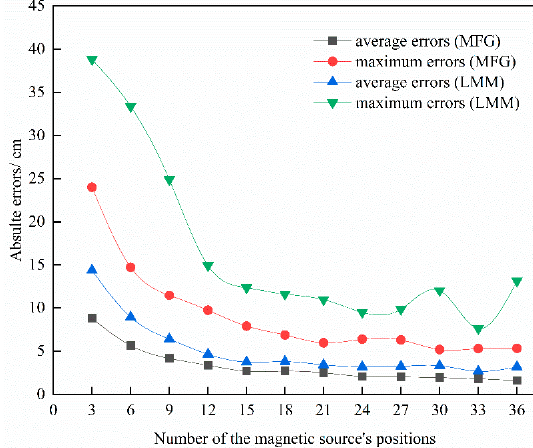
Figure 3. The comparison between LMM and MFG.